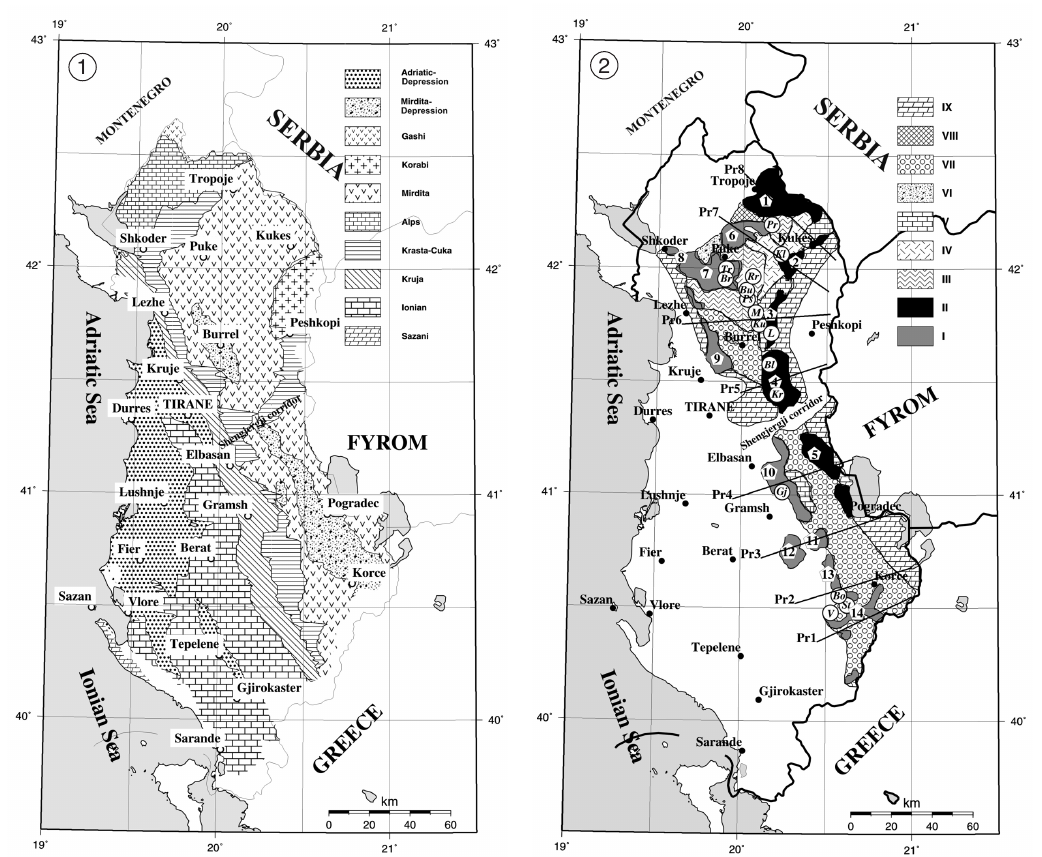
Fig. 1. Simplified geologic map of Albania with the sample sites at the ophiolitic rocks. The tectonic zones are: Sazani, Ionian, Kruja, Krasta-Cukali, Alps, Mirdita, Korabi, Gashi, depression of Mirdita zone and Peri-Adriat- ic depression. Fig. 2. A simplified geologic map of Mirdita zone. I – western belt; II – eastern belt; III – volcanic rocks; IV – gabbros; V – Cretaceous limestones; VI – Tithonian breccia; VII – Paleocene Quaternary sedimentary rocks; VIII – Heterogeneous ophiolitic mélange ; IX – Upper Triassic-Lower Jurassic limestones. The codes in the cy- cles taken from table I and denote the sites where the rock samples were extracted for laboratory measure- ments. The numbers in polygons denote the ophiolitic massifs. 1 – Tropoja; 2 – Kukesi; 3 – Lura; 4 – Bulqiza; 5 – Shebeniku-Pogradec; 6 – Krrabi; 7 – Terbuni; 8 – Gomsiqe; 9 – Skenderbeu; 10 – Shpati; 11 – Vallamara; 12 – Devolli; 13 – Voskopoja; 14 – Morava. The location of the eight profiles, where 2.5D modeling was at- tempted, is shown as well ( i.e.